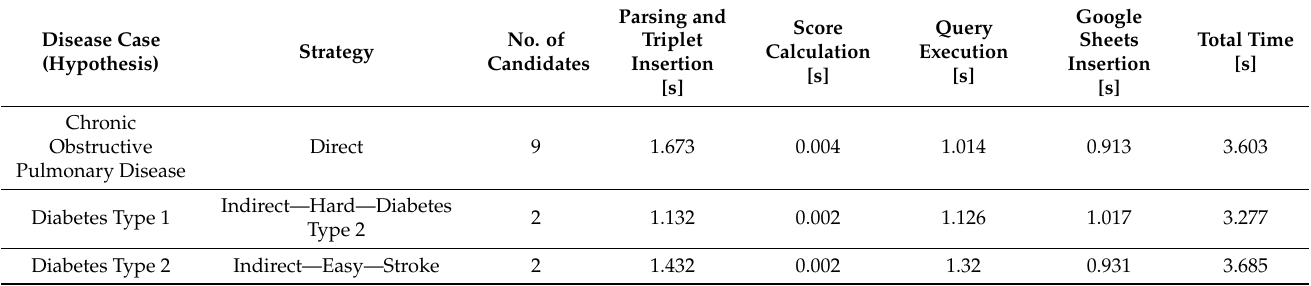
Table 3. Evaluation results for automated generation of questions relying on SCT